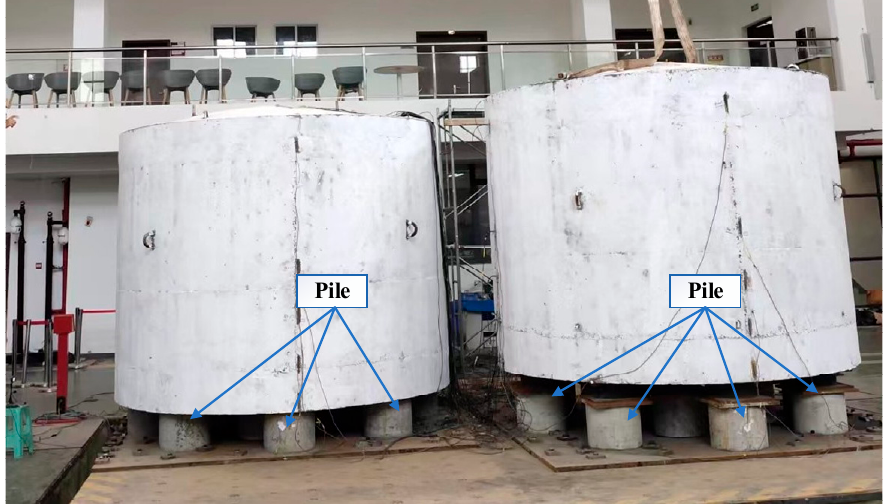
Figure 4. The experimental model of liquid natural gas [21].